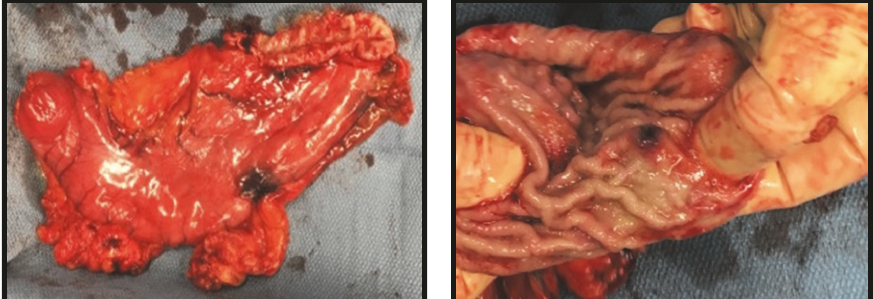
Figure 1: Left: gross whole specimen of the subtotal gastrectomy specimen, 14cm in length. Preoperatively marked on endoscopy with ink along the greater curvature. Right: proximal lesion near the serosa measured to be 1.1cm x 1cm was found to be normal gastric mucosa. Distal and proximal margins of the resection were found to be negative.